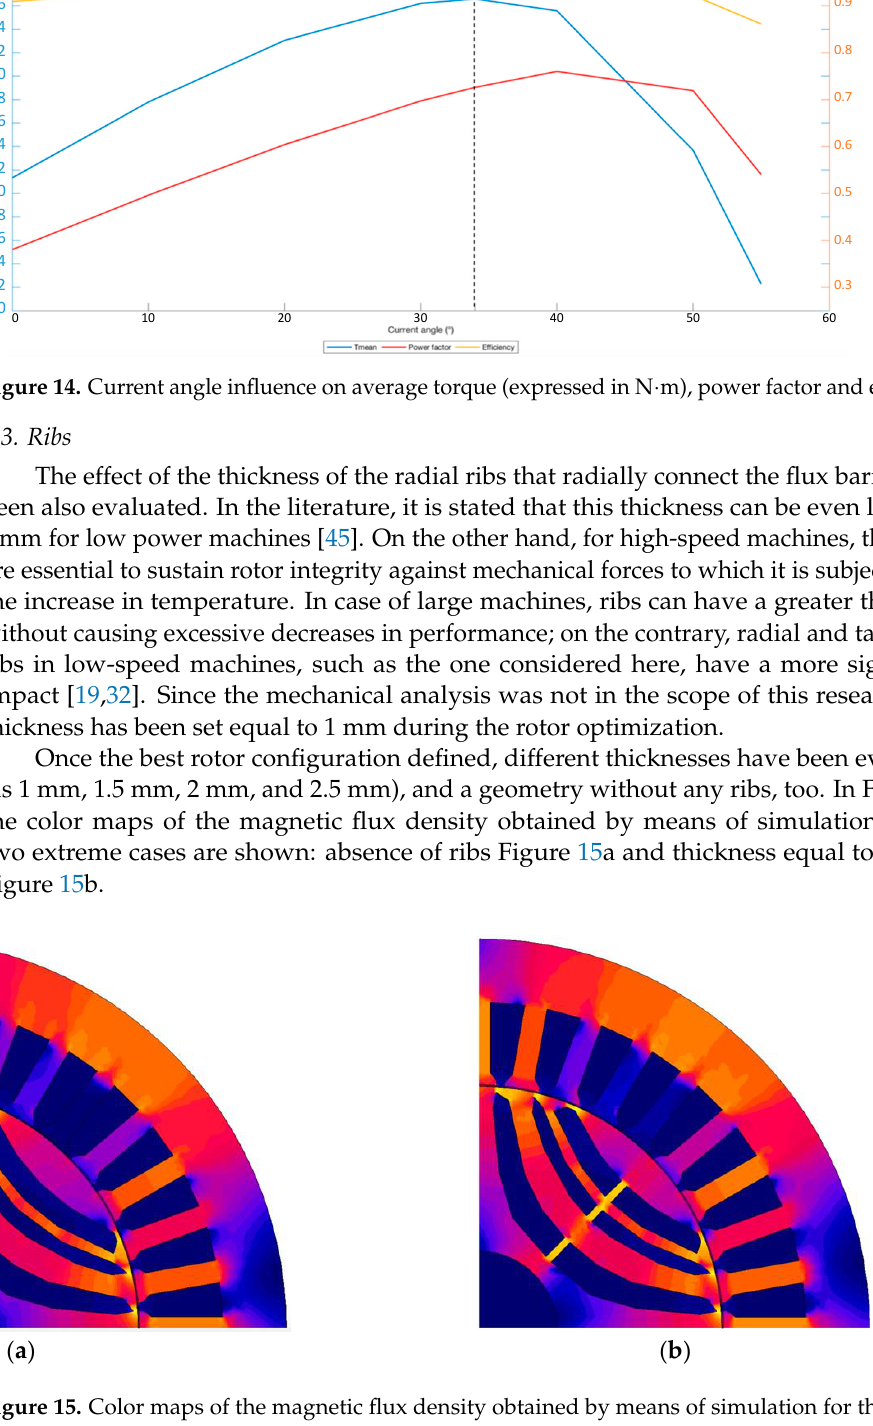
Figure 16. Rib width influence on the mean torque. Figure 17. Rib width influence on power factor. 3.4. Double-Layer Winding Usually, for low-power machines a single layer of conductors in the stator slots is preferred, and there is only one phase in each slot; this is in fact simpler from a technolog- ical point of view. However, it is interesting to see how the performance of the machine is influenced by employing a double-layer. In particular, this allows the consideration of a short-pitched winding case, otherwise not possible in a single-layer configuration. It means that conductors of different phases share the same slot. This undoubtedly implies a greater complexity in arranging the windings and a higher risk of winding faults. In this